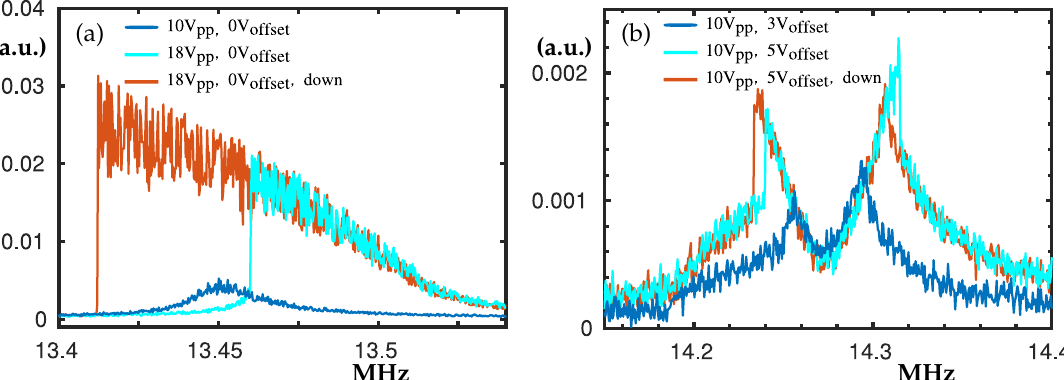
Figure 7. Experimental frequency swipes centred at about 13.45 MHz and 14.3 MHz. In panel ( a ) V of f = 0 V. The blue curve denote V pp = 10 V while the cyan together with the red curve are the swipe-up and -down for V pp = 18 V. In panel ( b ) the blue curve denotes swipe up for V of f = 3 V and V pp = 10 V. Cyan and red curves denote swipe-up and -down for V of f = 5 V and V pp = 10 V. The peak at about 14.3 MHz appears at twice the frequency of the peak shown in Figure